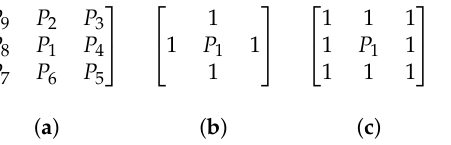
Figure 4. ( a ) 3 × 3 window showing 8-neighborhood of a pixel; ( b ) 4-connectivity; ( c )